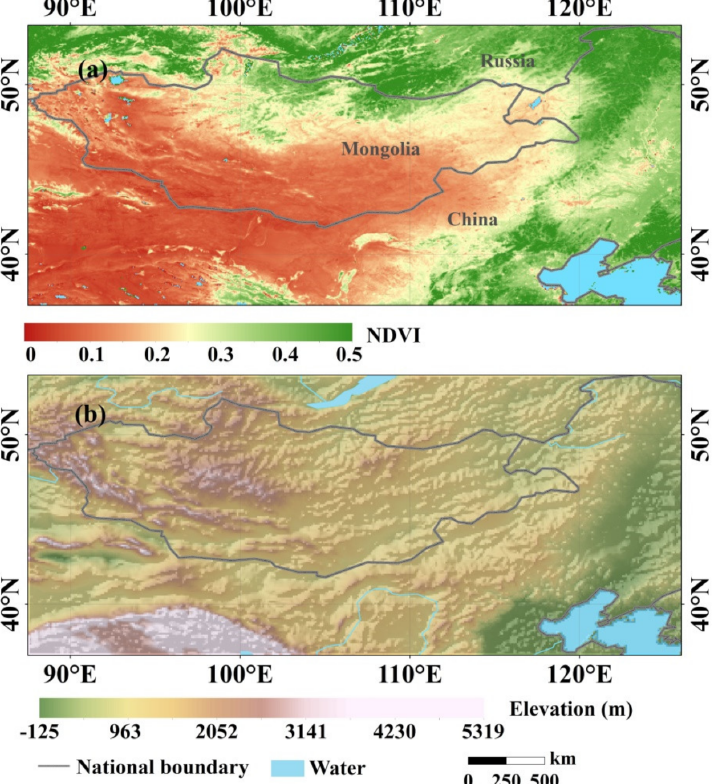
Figure 1. Overview of research area. ( a ) The annual MODIS normalized difference vegetation index (NDVI) during the period 2003–2020, ( b ) digital elevation